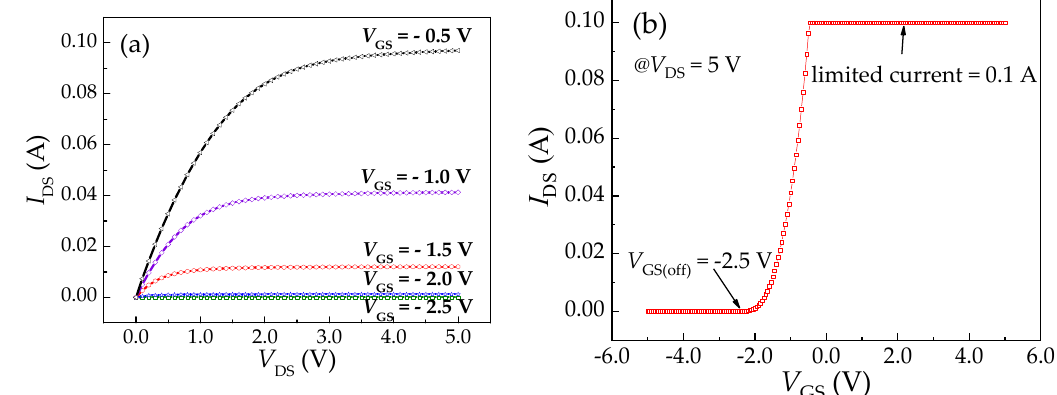
Figure 8. Characteristics curves of the MOSFET: ( a ) I DS -V DS characteristics curves; ( b ) transition characteristic